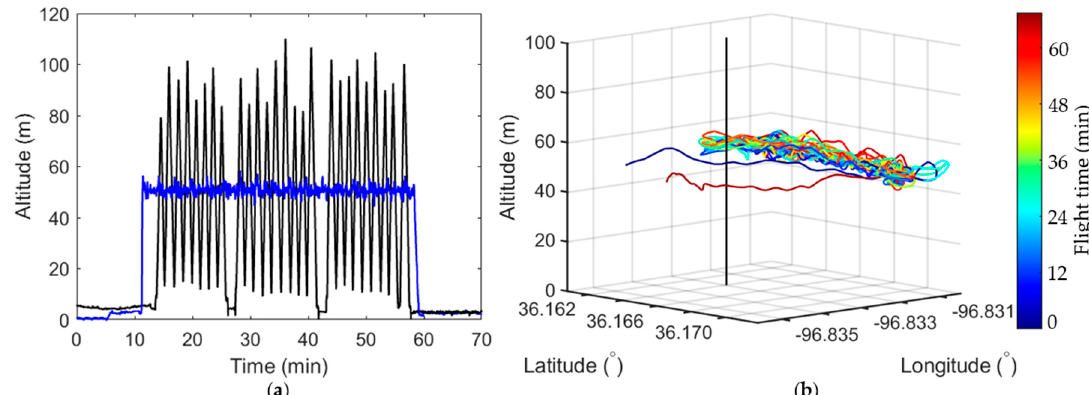
Figure 2. The flight patterns for data collection versus the altitude above ground level (AGL). ( a ) The horizontal profile for (blue) Skywalker X8 and (black) vertical profile for DJI P3 aircrafts. ( b ) The time series for the progression in the global positioning system (GPS) coordinates with altitude for (rainbow color gradient line) the horizontal and (monochromatic black line) vertical flight paths followed by the Skywalker X8 and DJI P3, respectively.